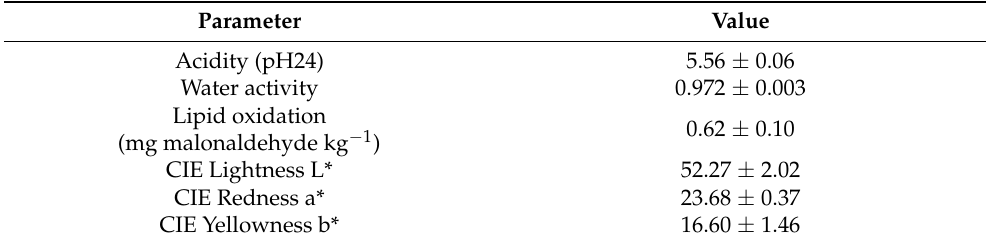
Table 3. Acidity, lipid oxidation, water activity, and color parameters of lamb (mean ± standard